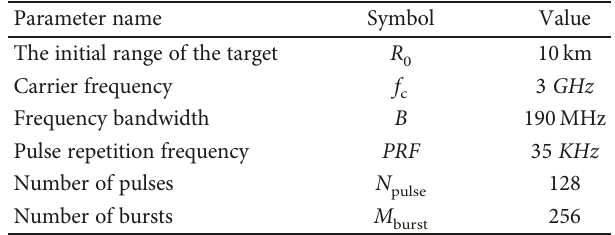
Table 1: The radar parameters for SFCW (stepped frequency continuous wave) illumination.